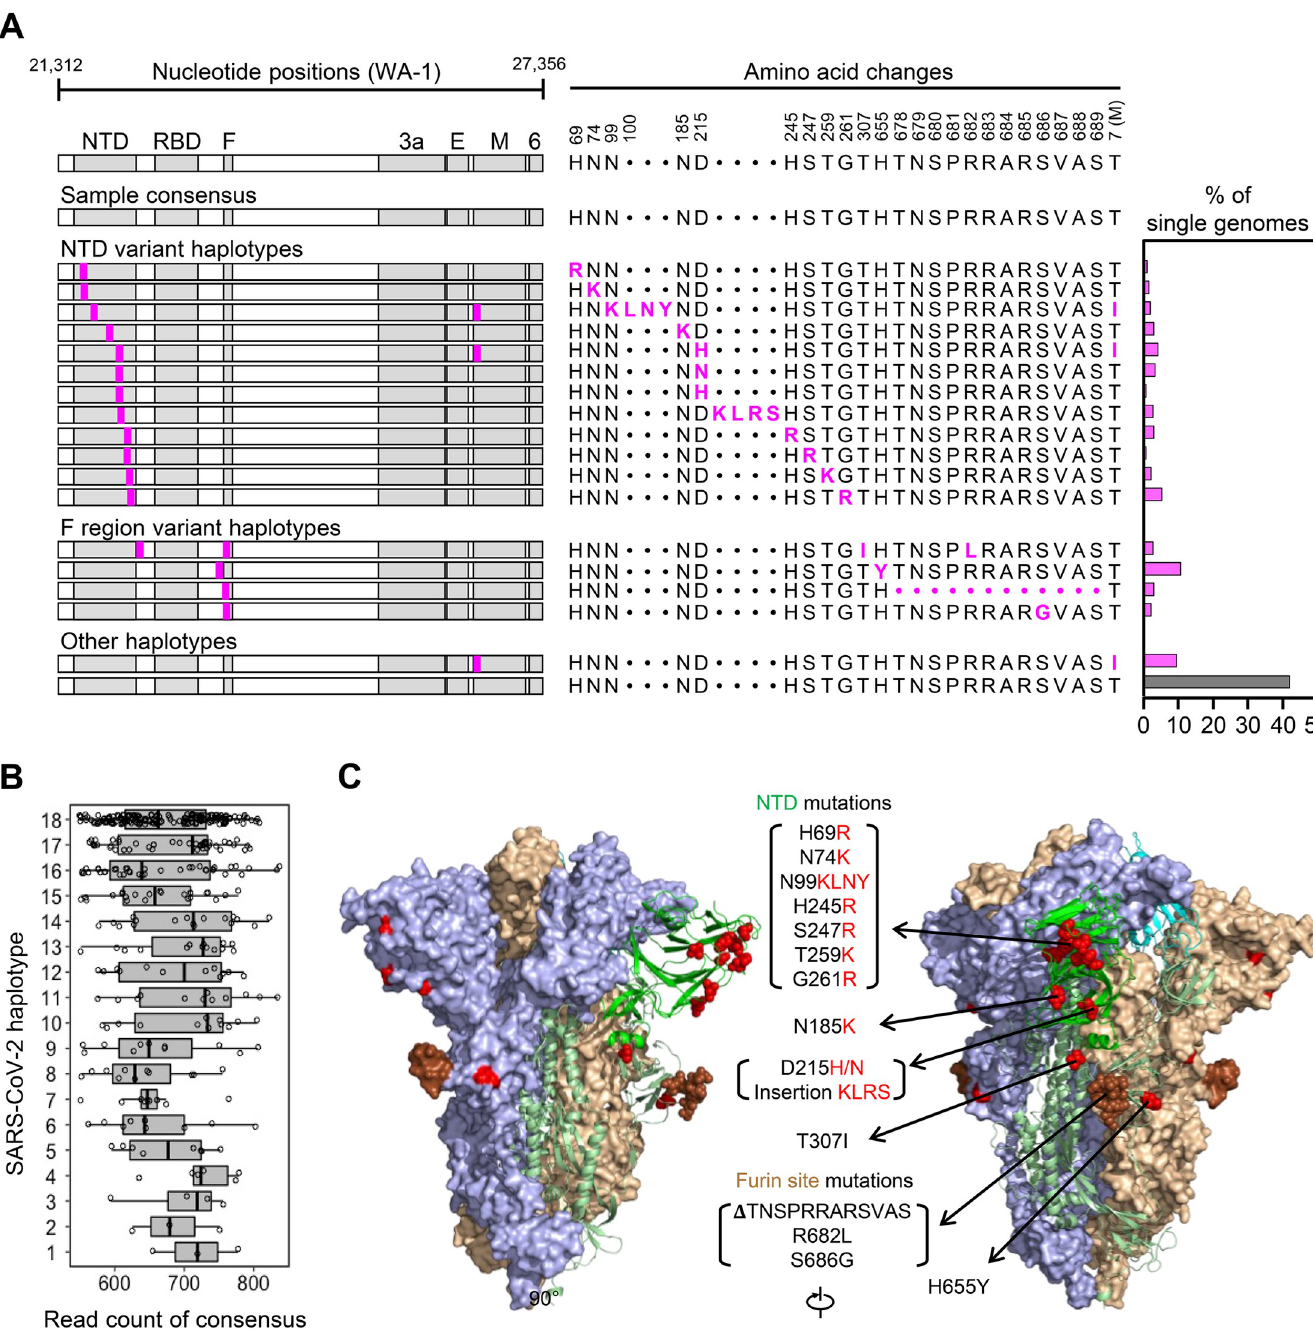
Fig 2. Analysis of SARS-CoV-2 genetic diversity in vitro . (A) Haplotype diagrams (left) depicting SARS-CoV-2 SGS detected in a 4 th -passage Vero cell culture of the WA-1 reference clinical isolate. Spike NH 2 -terminal domain (NTD), receptor-binding domain (RBD), and furin cleavage site (F) regions are shaded grey, with remaining regions of spike in white. Pink tick marks illustrate mutations relative to the sample consensus sequence. Amino acid changes corresponding to these mutations are shown in sequence alignment form (middle), with the percentage of all SGS in the sample matching each haplotype shown in the bar graph (right). The grey bar in the graph indicates the haplotype that matches the sample consensus sequence; variant haplotypes with at least 1 mismatch to sample consensus are in pink. (B) Read counts of each UMI bin for which the SARS-CoV-2 sequence matched each of 18 different haplotypes in Vero cell culture of the WA-1 clinical isolate. Bars indicate median read counts among bins. (C) Mapping of detected spike gene mutations on the trimer structure. Two protomers of the SARS-CoV-2 spike (PDB ID: 6zge) are shown in surface representation and colored light blue and wheat, respectively. The third protomer is shown in cartoon representation with the NTD region colored in bright green. NTD mutations as well as T307I and H655Y are shown in red and the furin cleavage site mutations are in brown. The molecular structures